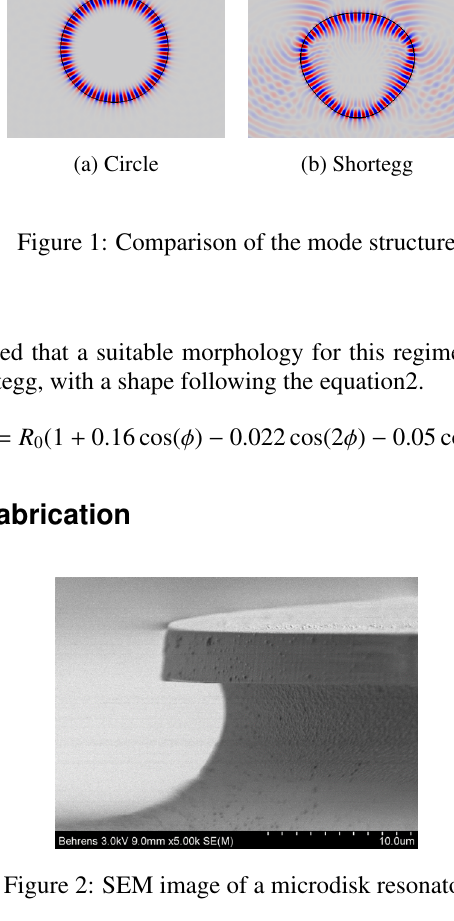
To investigate the behavior and potential applications of deformed cavities establish a fabrication process that